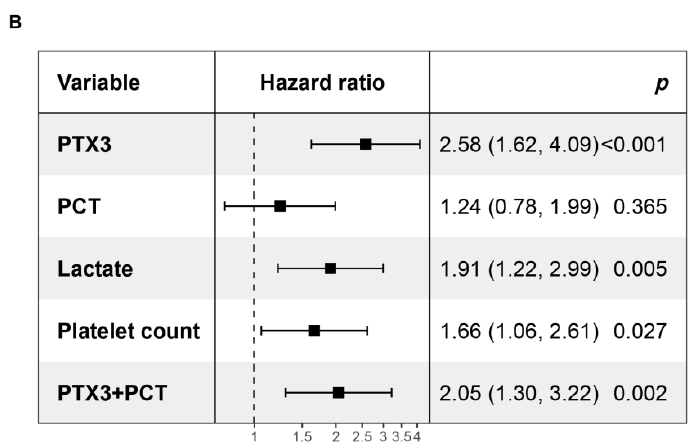
Figure 5. Survival analysis for sepsis patients without or with shock. ( A ) Kaplan–Meier survival curves for patients between high and low levels of pentraxin-3 (PTX3), the dashed lines represent those with PTX3 levels above the cut-off value (11.12 ng/mL). ( B ) Forest plot of adjusted hazard ratios for septic shock patients relative to sepsis patients without shock with levels of biomarkers below cut-off value by univariate and multivariate Cox regression analysis. Hazard ratios are adjusted for age and gender.